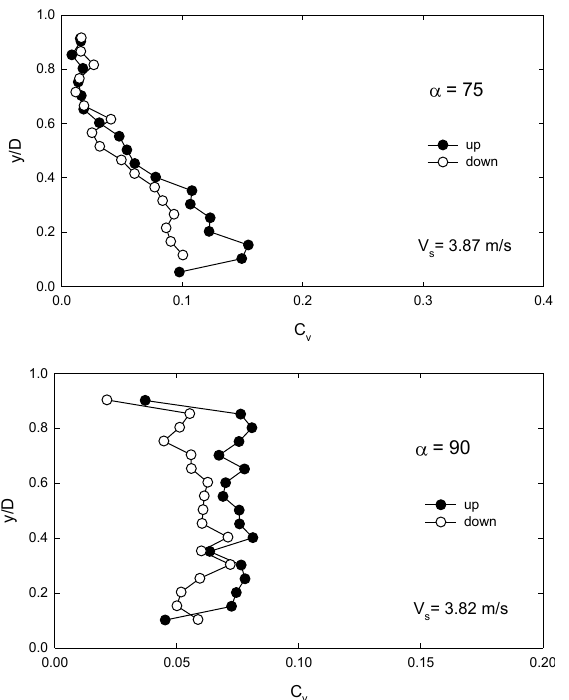
Fig. 4. Effect of the inclination angle  and the mean mixture velocity V s on profiles of local concentration c v (transport concentration c d ≈ 0.06).